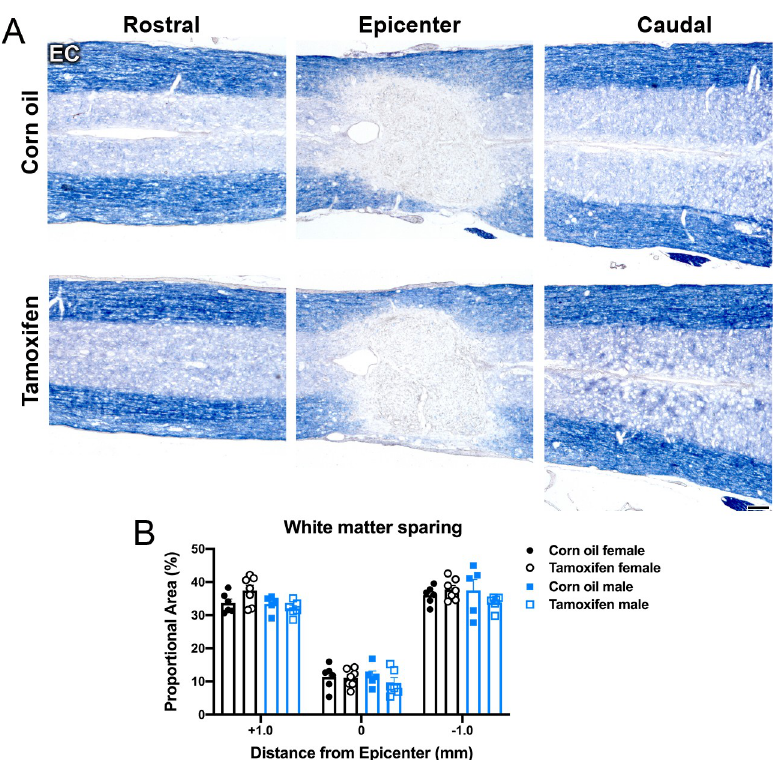
Fig 3. Delayed tamoxifen treatment does not change the amount of white matter spared at the lesion epicenter, or distal to the lesion. (A) Representative images of control and tamoxifen mice stained for eriochrome cyanine (EC) at the lesion epicenter, and 1 mm rostral and caudal to the epicenter. Scale bar = 100 μ m. (B) Area of EC staining was not significantly different between control and tamoxifen mice or female and male mice at 1 mm rostral to the epicenter, at the epicenter, or 1 mm caudal to the epicenter. Data presented as mean + SEM. Two-way repeated measures ANOVA with Sˇı´da´k post hoc test; corn oil female n = 6; tamoxifen female n = 7; corn oil male n = 5; tamoxifen male n = 6.